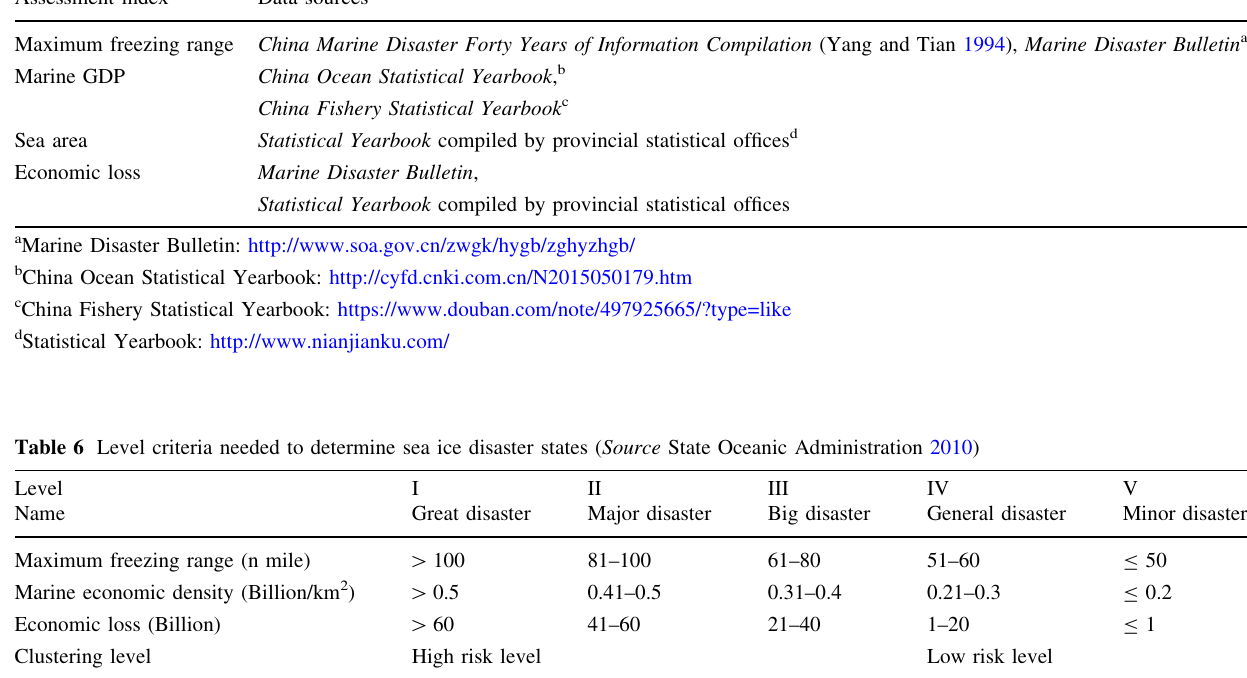
Table 5 Data sources for sea ice disaster and economic losses in Liaoning, Shandong, Hebei, and Tianjin, China, 1951–2015 Assessment index